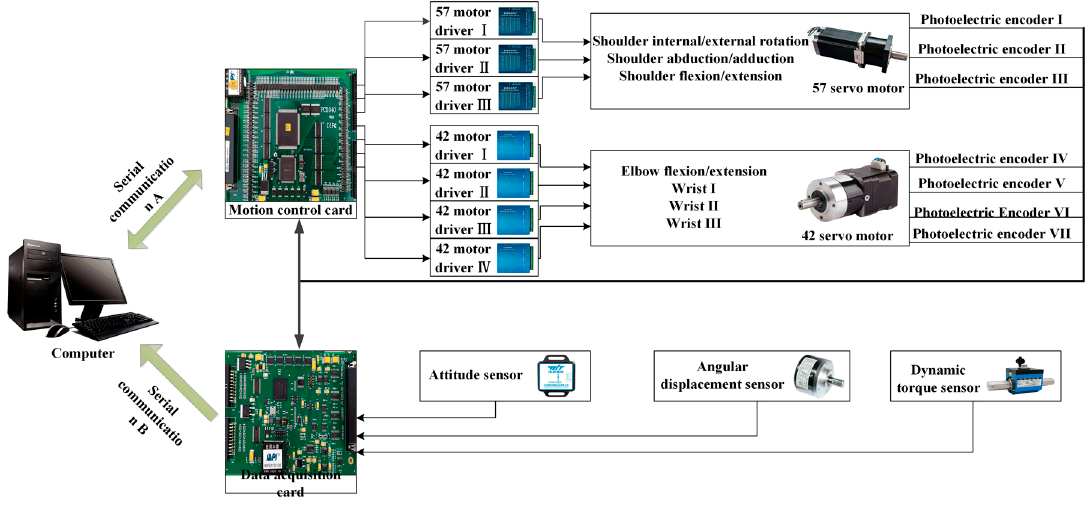
Figure 12. Block diagram of rehabilitation robot control